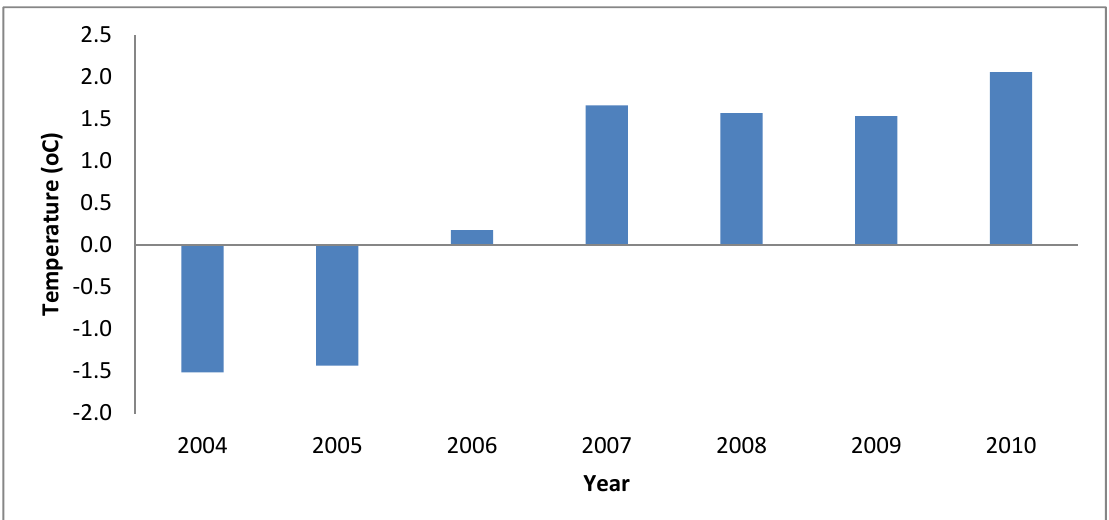
Figure 5. Total average annual temperature (°C) anomalies in Ejura-Sekyedumase Municipality (2004–2010); NB: total average annual temperature (1971–2000) for the municipality is 26.3 °C .